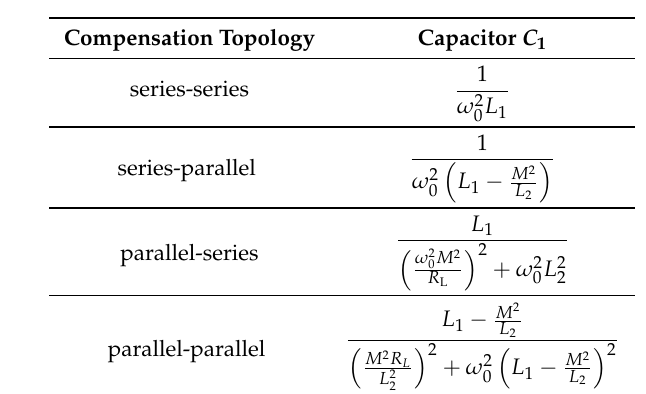
Figure 2. Circuit representation of the four basic compensation topologies. Table 1. Relationships for the transmitter compensation capacitor